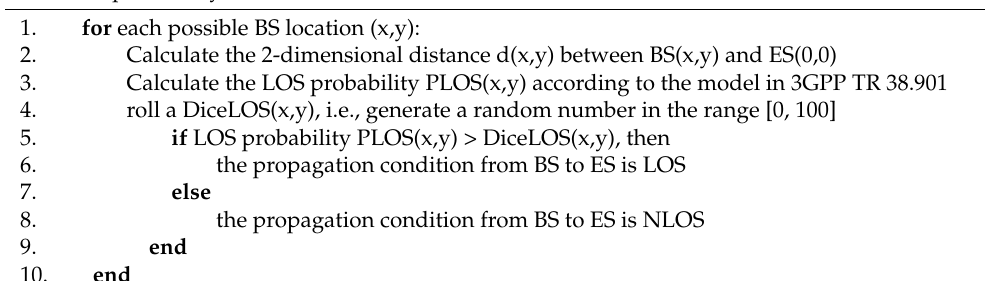
Figure 5. Path loss propagation model. Algorithm 1 Pseudocode for LOS and NLOS distance functions based on a random mechanism and LOS probability.